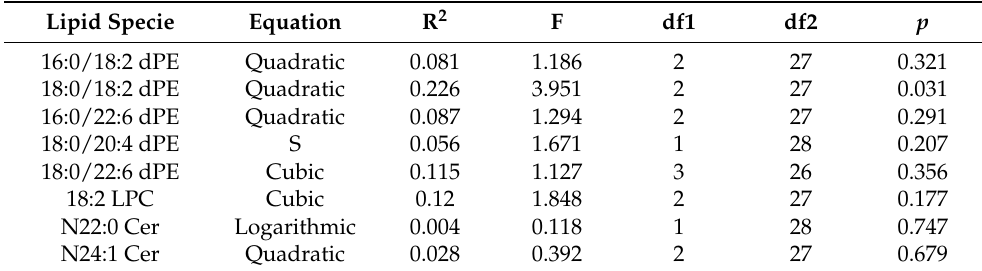
Table 2. Correlation of SLEDAI score with the compositions of altered lipid species with optimal curve